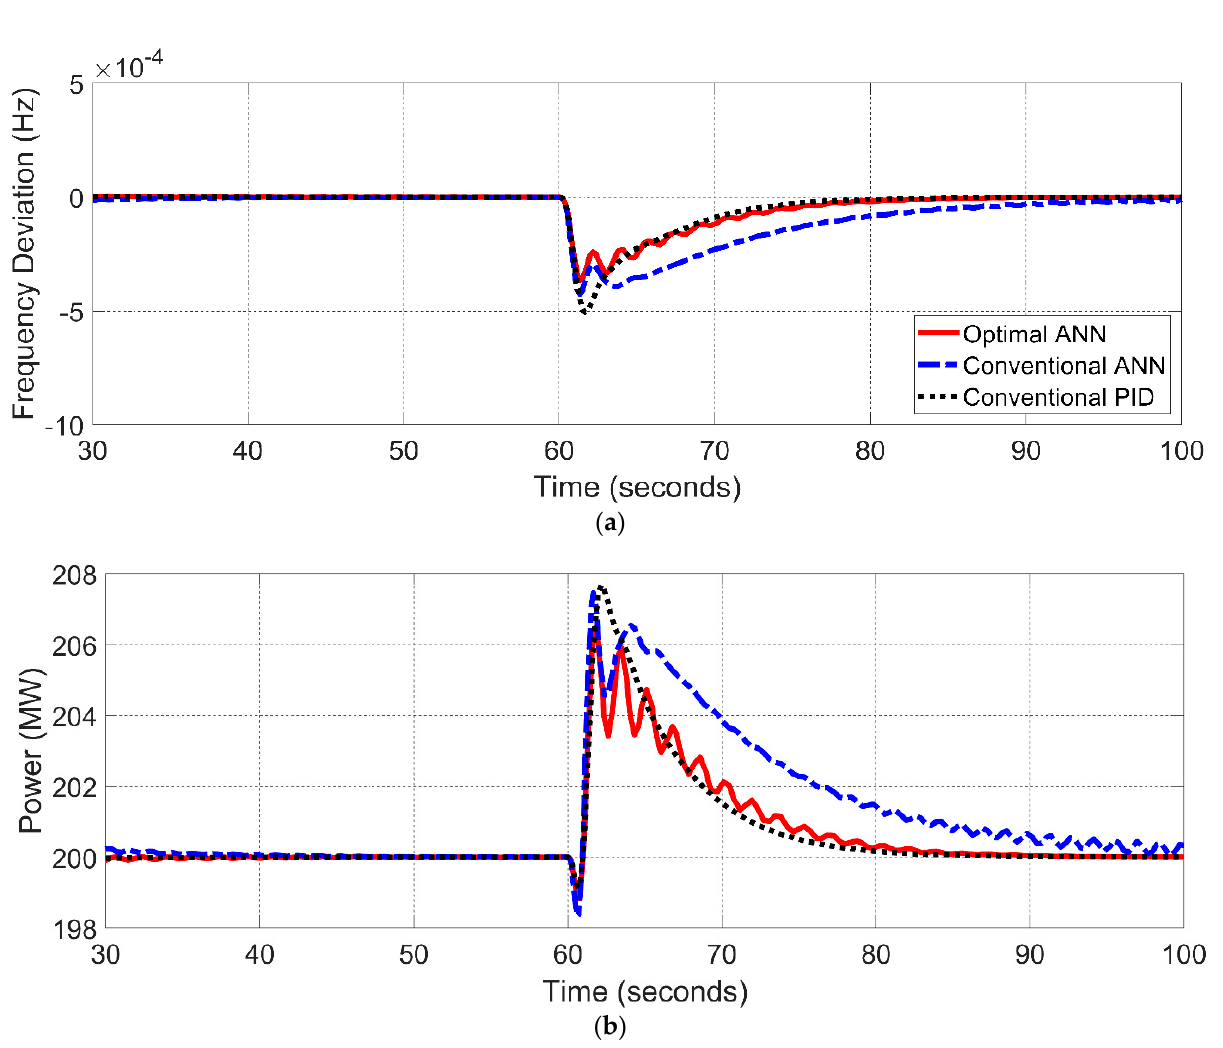
Table 8. ITAE for optimal ANN, conventional and PID methods.